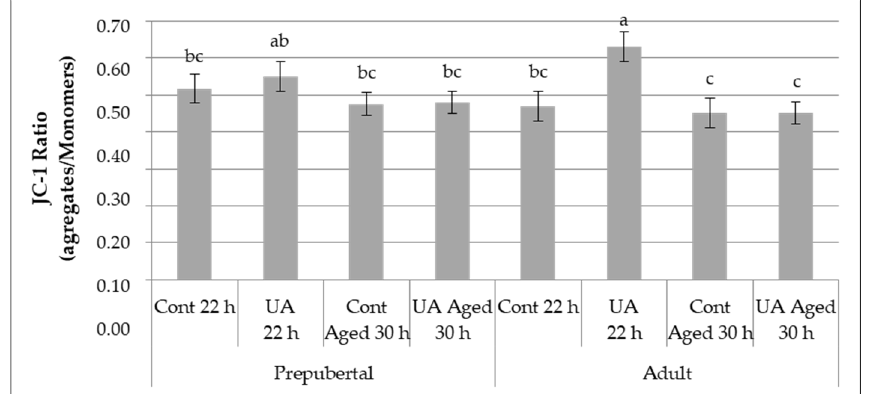
Figure 3. Effect of the Urolithin A (UA) supplementation to the maturation medium, cumulus-oocyte-complexes (COCs) aging and female age on mitochondrial membrane potential (MMP). The assessment of mitochondrial activity was performed using the average of the ratios (aggregate/mon- omers) for each oocyte analyzed in each group (prepubertal: control 22 h, UA 22 h, control aged 30 h, UA aged 30 h; adult: control 22 h, UA 22 h, control aged 30 h, UA aged 30 h groups). Different letters indicate significant differences between groups ( p < 0.05). Data are expressed as the mean ratios ± standard error mean (SEM).